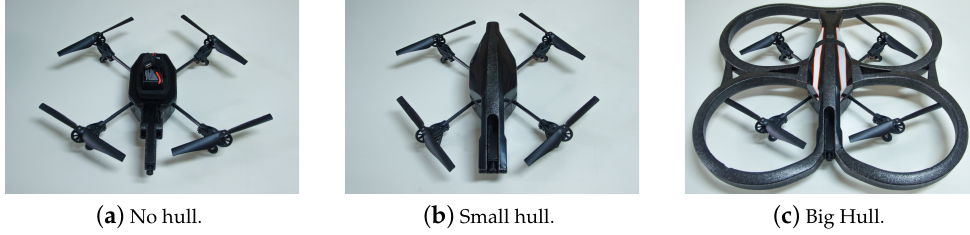
Figure 3. The quadrotor Parrot AR.Drone without a hull and with the two hulls designed for it.